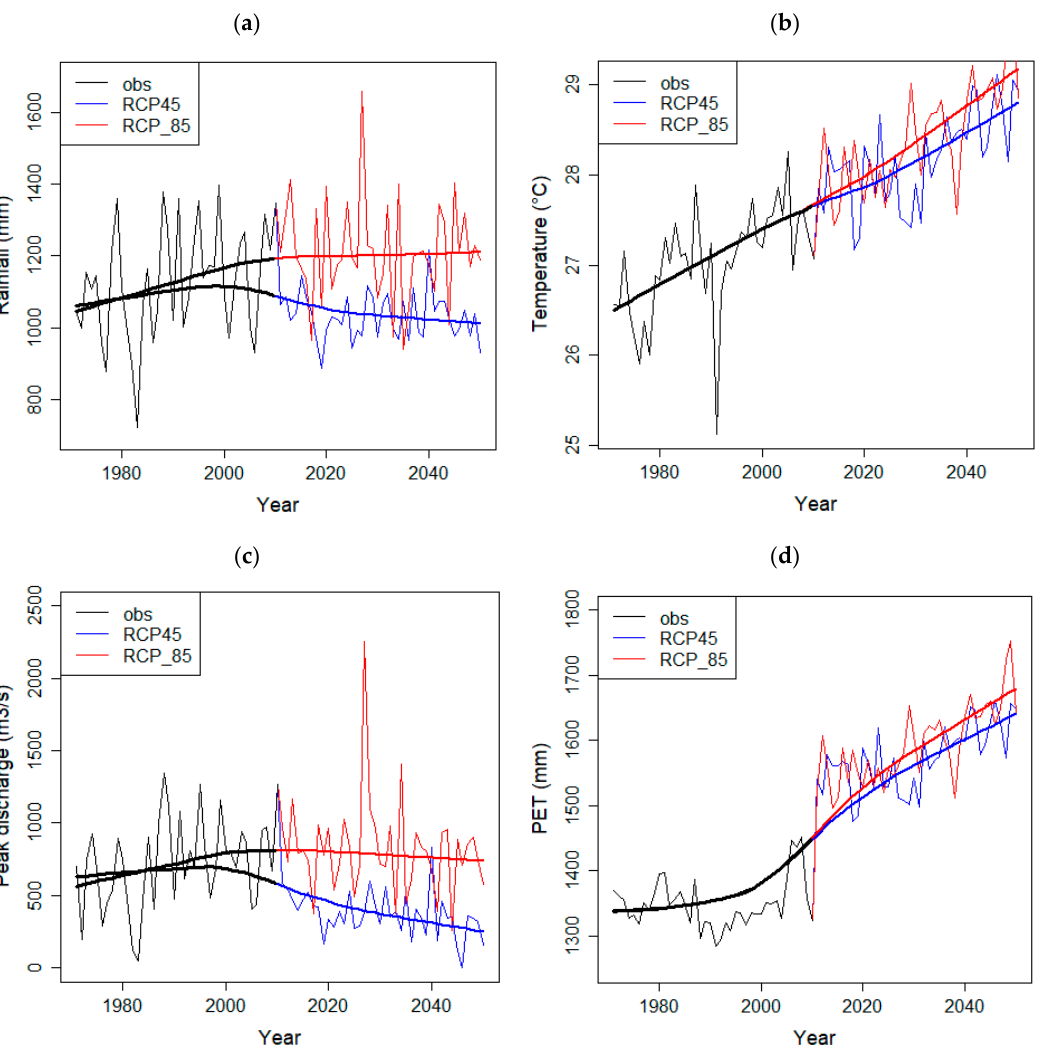
Figure 12. Change in annual rainfall ( a ), temperature ( b ), potential evaporation ( c ) and peak flow ( d ) from observation to projection based on the Representative Concentration Pathways RCP 4.5 and RCP 8.5 over the period 1971–2050.